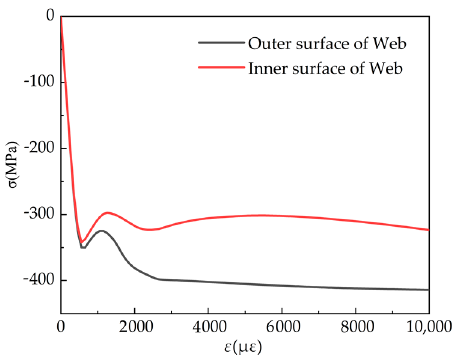
Figure 19. Curves of inner and outer surfaces of web plate. Energies 2019 , 12 , x